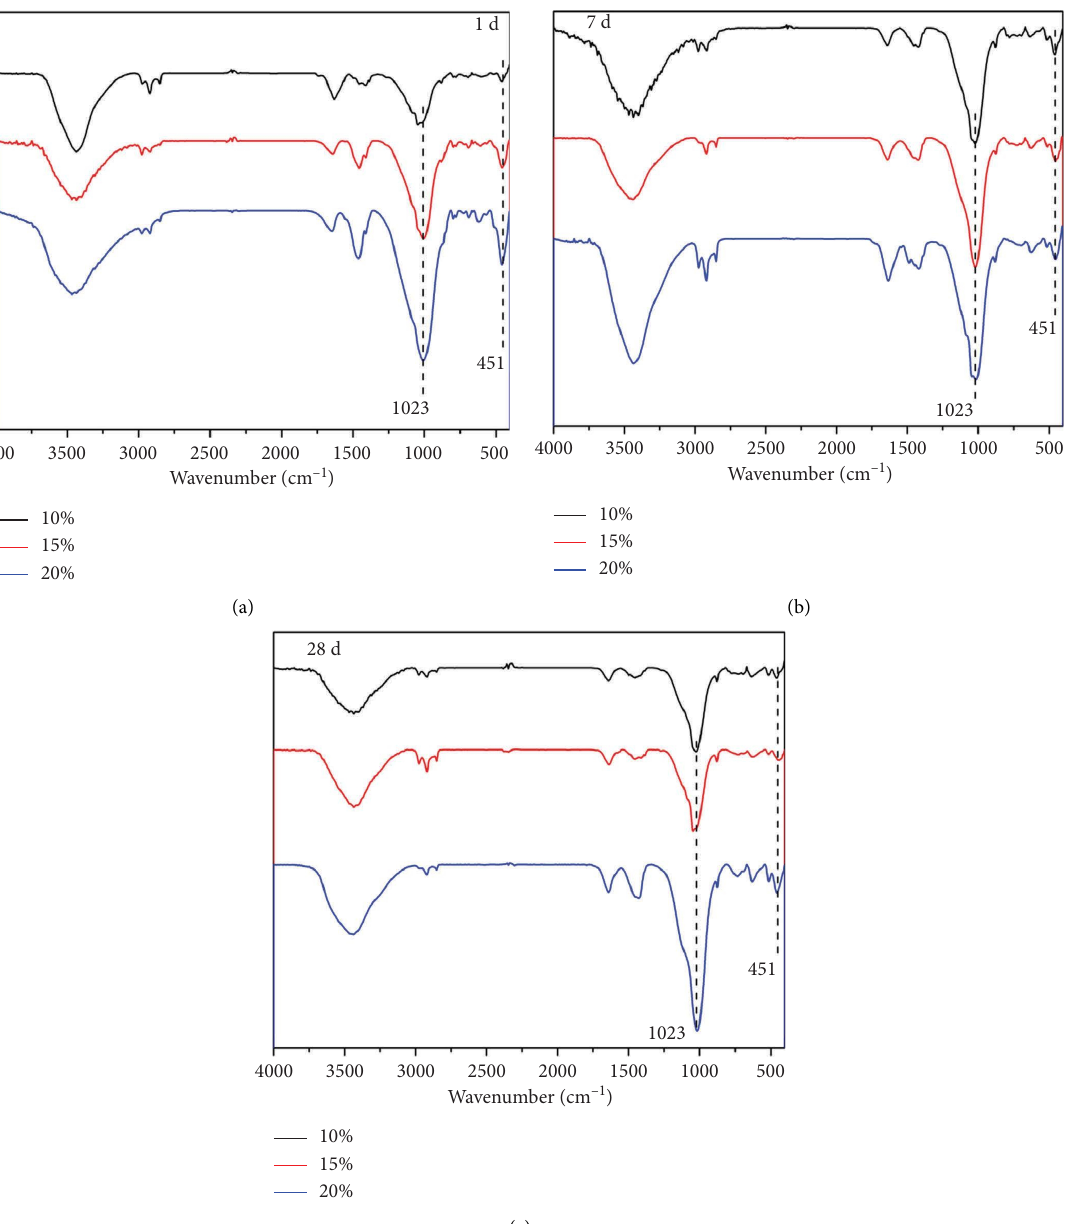
Figure 6: Te IR spectra of FABG with diferent sodium hydroxide contents after curing at 90 ° C: (a) 1d; (b) 7d; (c) 28